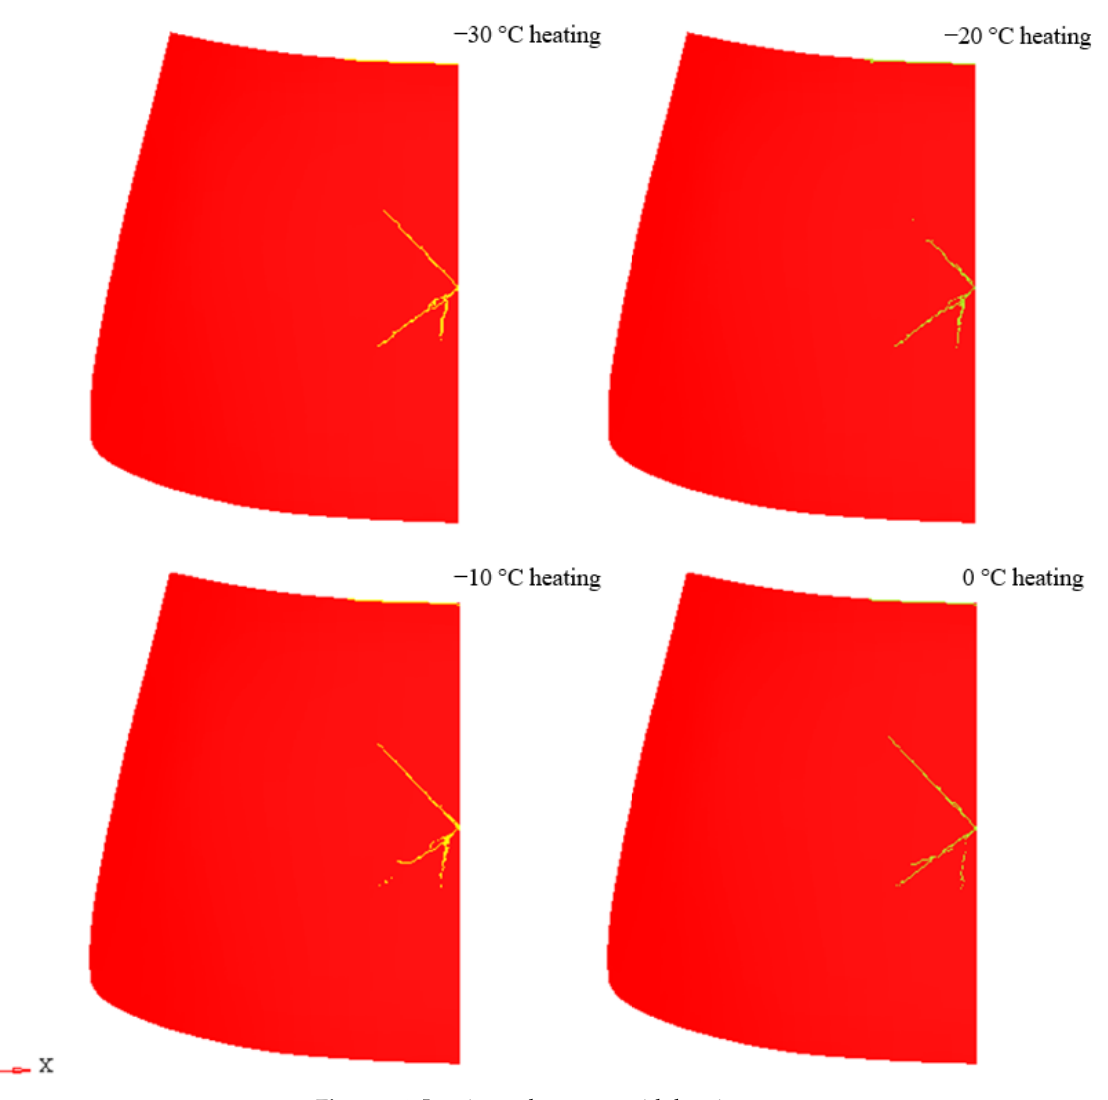
Figure 14. Laminate damage—with heating.